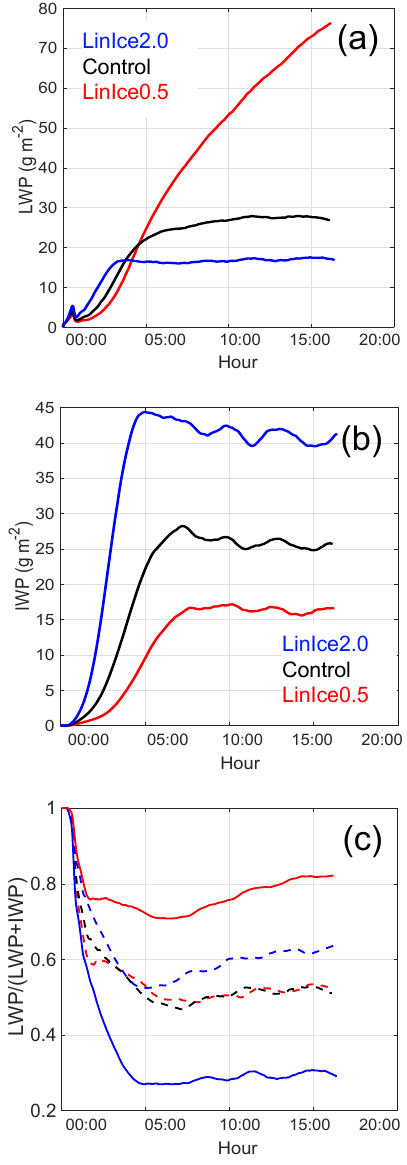
Figure 6. Time series from runs varying CCN concentrations with “linear” ice formation. (a) LWP, in units of gm − 2 . (b) IWP, in units of gm − 2 . (c) Liquid water fraction for ConIce (solid) and LinIce (dashed). For CCN and INP factors 0.5 (red), 1.0 (black), and 2.0